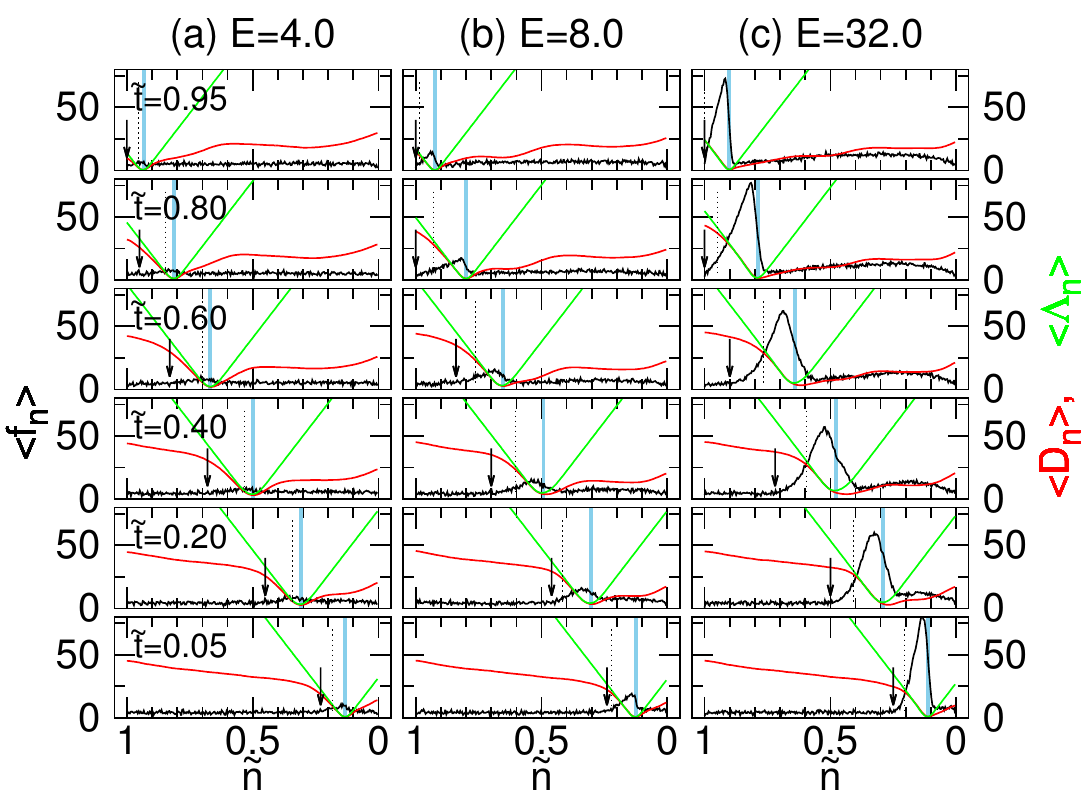
Figure 6. Variation of the bond tension (cid:104) f n (cid:105) (the black curves) for N = 256 at a set of scaled time points ˜ t (values indicated in the figures) at the driving fields: ( a ) E = 4.0; ( b ) 8.0; and ( c ) 32.0. The direction of the scaled ˜ n -axis is reversed so that the monomers entering the trans region stay on the right-hand side of the plot while the cis monomers rest on the left-hand side. The sky-blue region indicates the monomers in the pore region. The direct distance (cid:104) D n (cid:105) and the contour distance (cid:104) Λ n (cid:105) to the pore are plotted in red and green colors, respectively. The values of (cid:104) D n (cid:105) and (cid:104) Λ n (cid:105) are read from the right y -axis of the figure. In each plot, a downward arrow indicates the location of the tension front, whereas a dashed line marks the boundary for the straightened chain section.